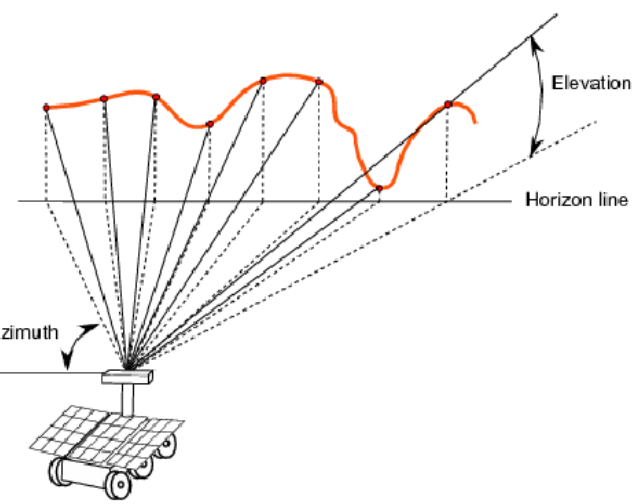
Figure 1. The Mars rover takes photos and extracts the